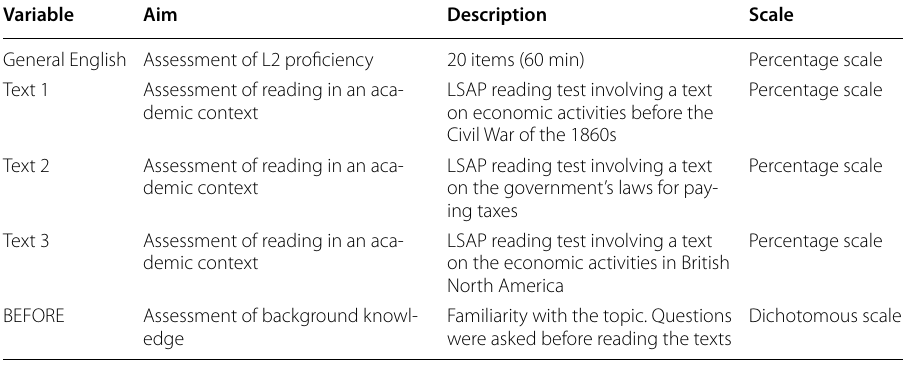
Table 3 The instruments used in the